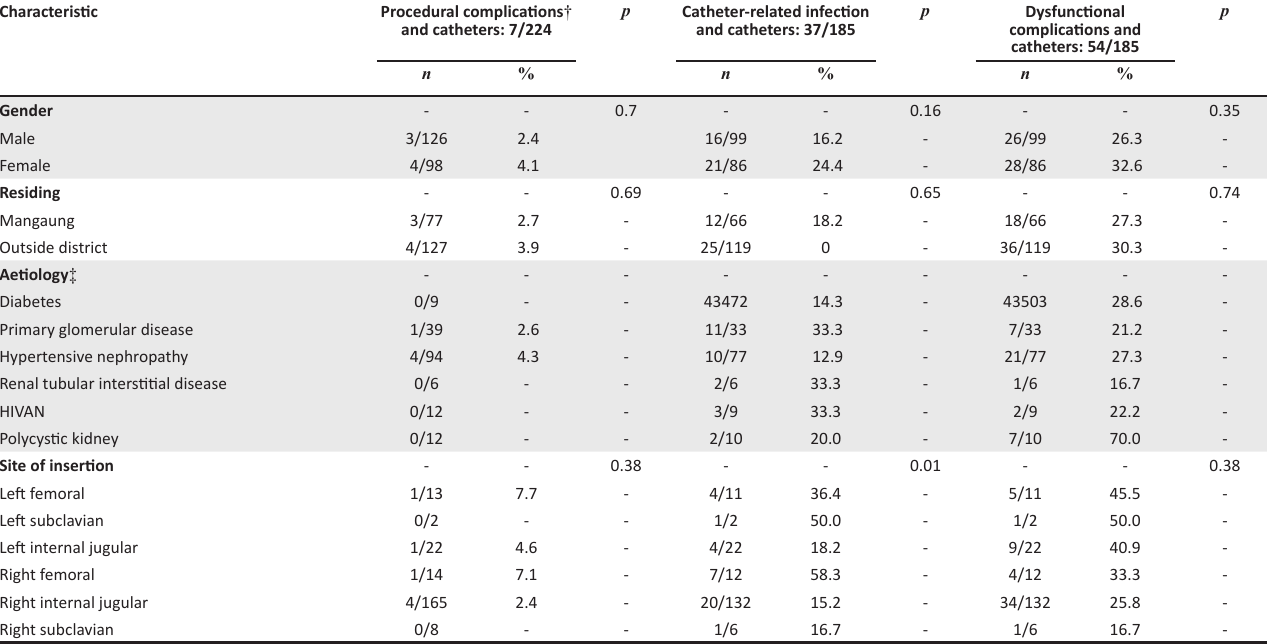
TABLE 4: Complications and associations per catheters.